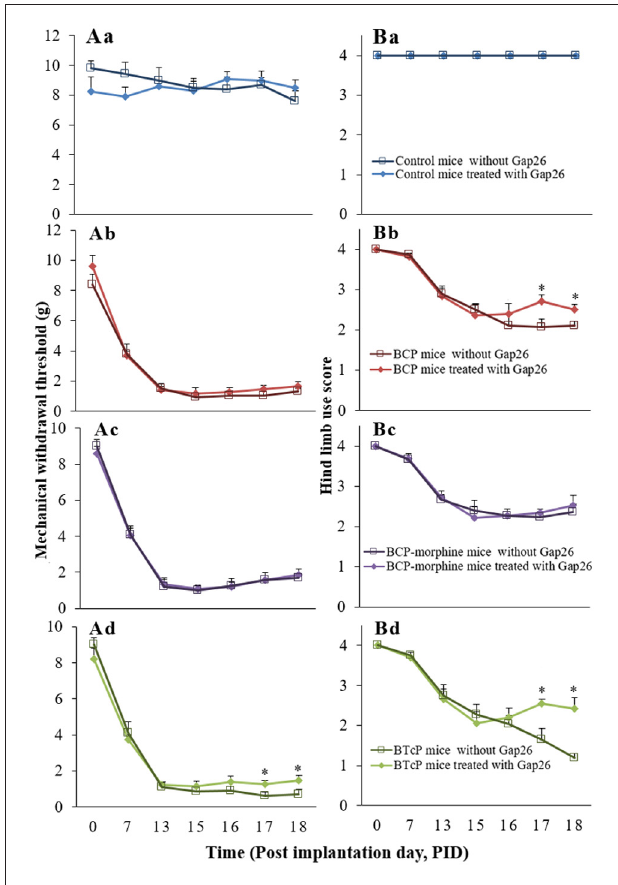
FIGURE 4 | Comparison of the PWMT of left hind paw (A) and hind limb use score (B) in normal, BCP, BCP-morphine and BTcP mice with or without Gap26 treatment. Gap26 (5 mg/kg/day) was administered by intrathecal injection once a day for 3 days in the last 3 days of experiment (PIDs 16–18). Pain behavioral tests of PWMT of left hind paw and hind limb use score in mice were performed at 8 am. Five mice were used for each group. ∗ P < 0.05, vs. mice without Gap26. The data were combined with the data of Figures 1 , 3